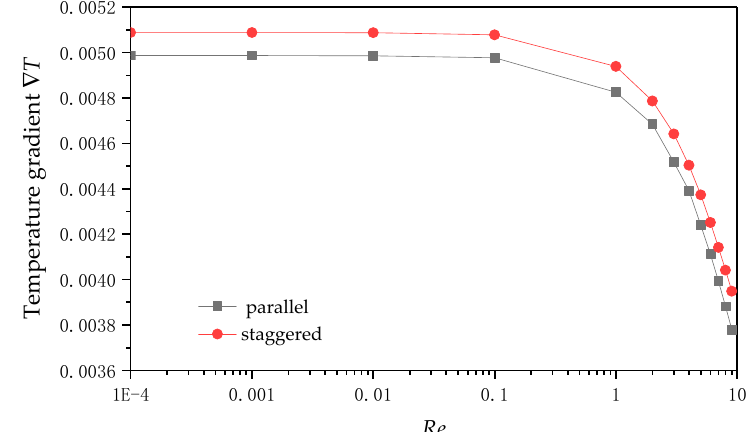
Figure 18. Relation between Reynolds number and temperature gradient of parallel and staggered structures.